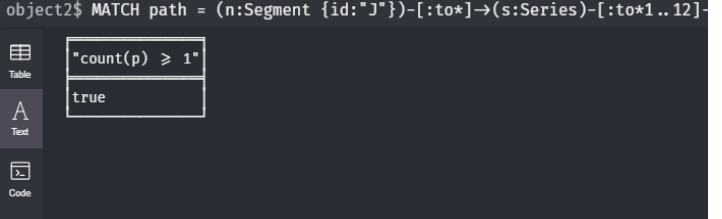
Figure 13. Visualisation of the output of query Q 9 run on the sensor network of Figure 4. The result is taken from the web interface of